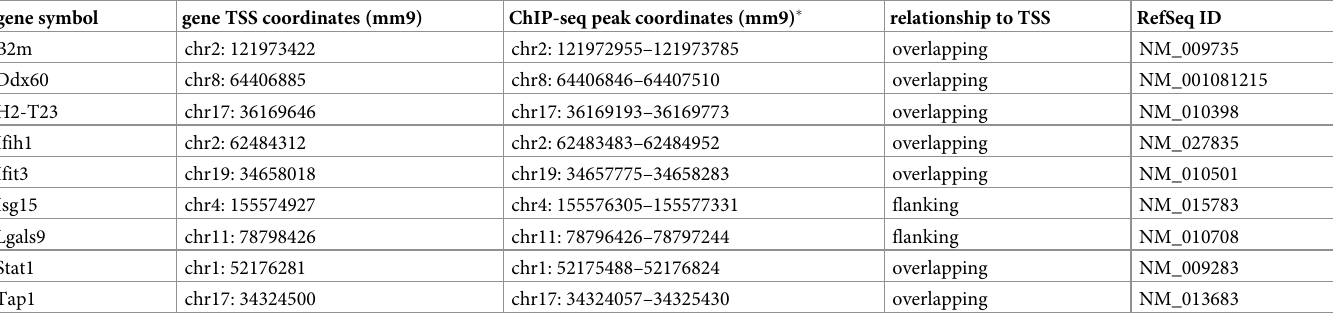
(cid:3) ChIP-seq peak coordinates reported by Webster et al. 2014 and converted from genomic build GRCh37/hg19 to NCBI37/mm9 using Galaxy Liftover function. Abbreviations: ChIP-seq, chromatin immunoprecipitation sequencing; MITF, melanogenesis associated transcription factor; mm9, mus musculus 9 genome build; RefSeq, Reference Sequence database; TSS, transcription start